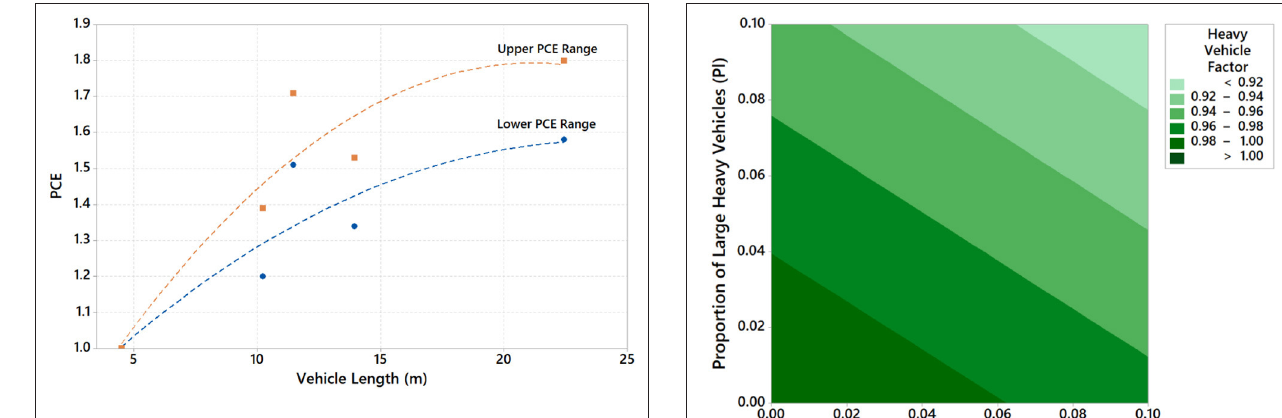
FIGURE 5 | Relation of vehicle length to PCE values. TABLE 5 | Recommended PCE values based on heavy-vehicle size and traffic demand.